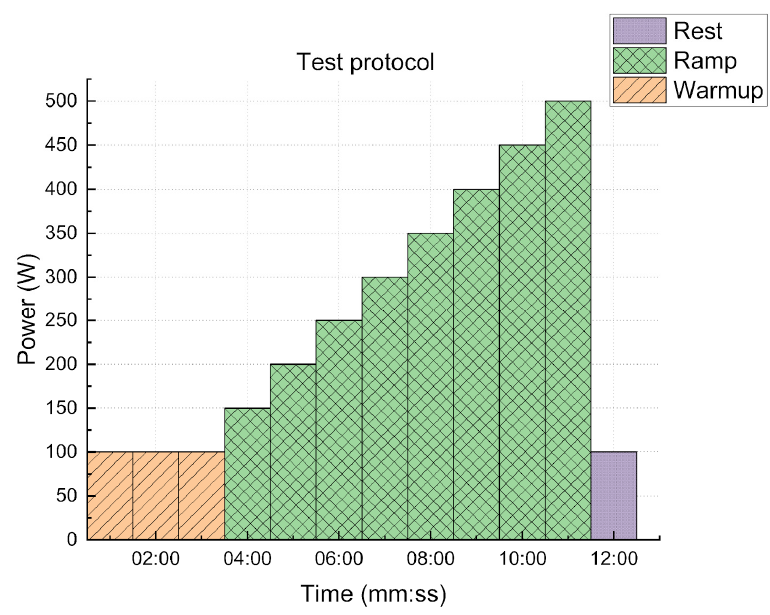
Figure 7. Ramp protocol example.